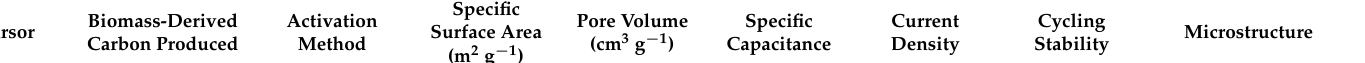
One-pot carbonization and activation, KOH/fig-fruit = 3:1, 900 °C,